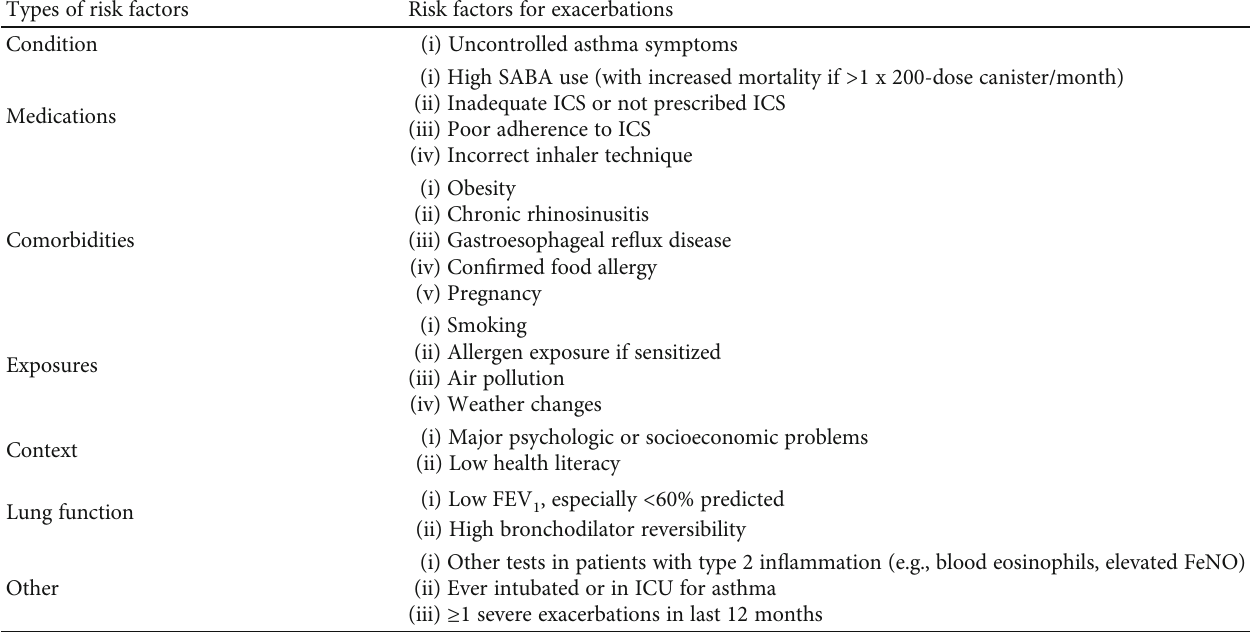
Table 2: Risk factors for poor asthma outcomes that increase the risk for exacerbation and may require stepped-up controller therapy. Types of risk